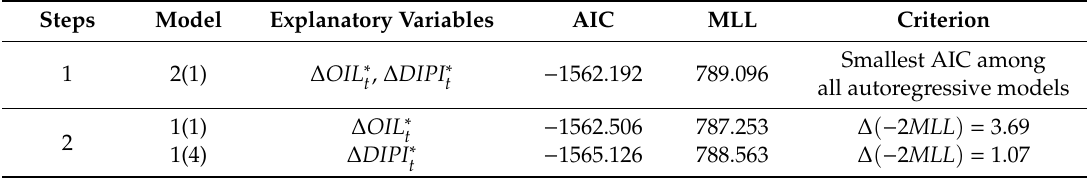
Table 5. Model Selection Process with Method 2 in